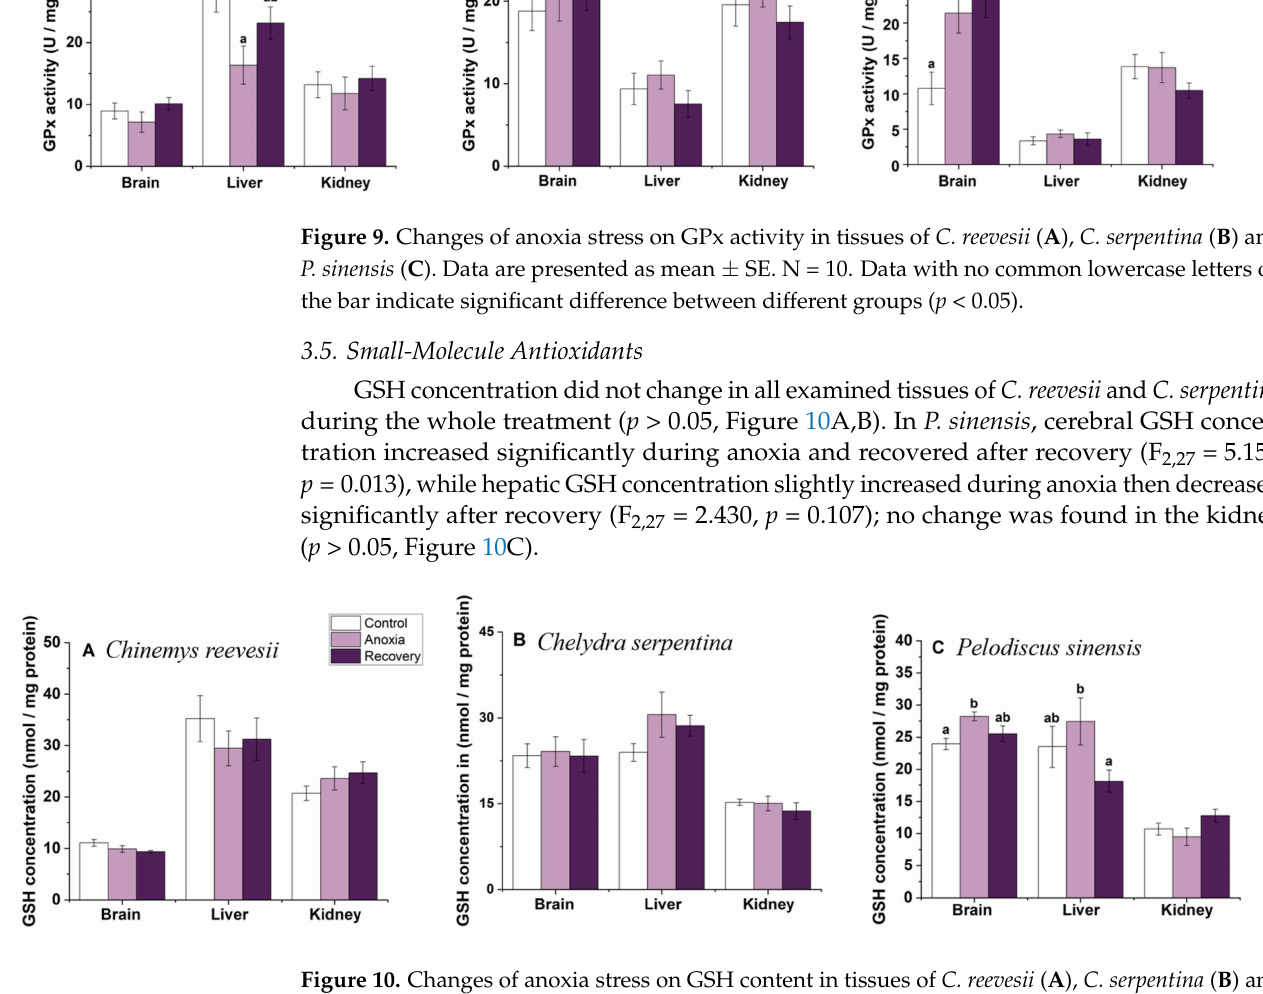
Figure 10. Changes of anoxia stress on GSH content in tissues of C. reevesii ( A ), C. serpentina ( B ) and P. sinensis ( C ). Data are presented as mean ± SE. N = 10. Data with no common lowercase letters on the bar indicate significant differences between different groups ( p <